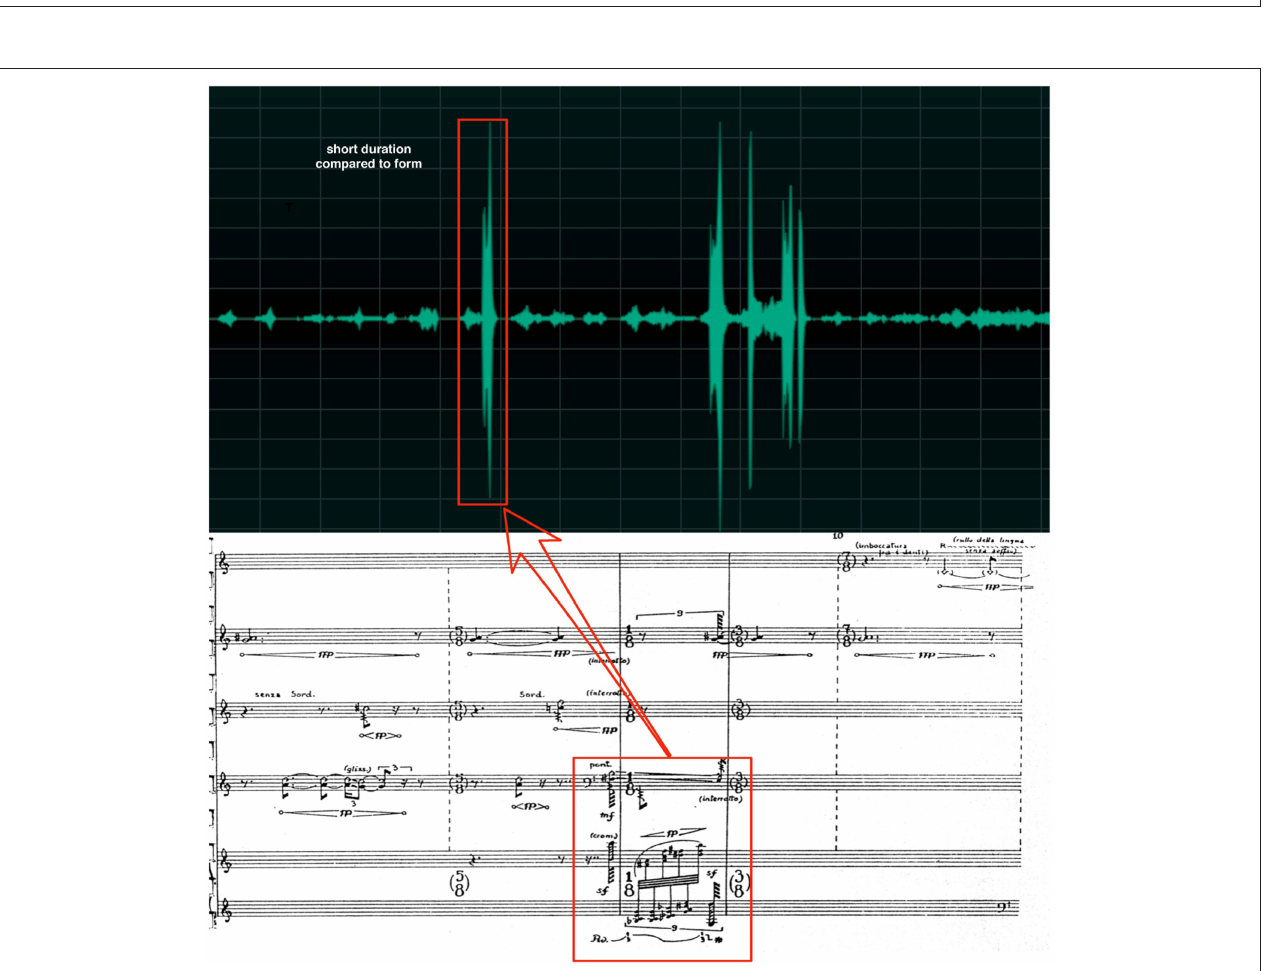
FIGURE 3 | The figure shows the beginning part of Salvatore Sciarrino’s Lo spazio inverso. For the majority of the piece, the dynamics is very soft (from ppp to p ) and the instrumentation does not include keyboards. All of a sudden, the keyboard is used in the piece with a dynamic of fff thus creating an immediate fracture in musical discourse. While these events are very scarse and sparse in time, they nonetheless represent the most important musical elements of the piece. In this context, a statistical approach aimed at finding most probable event, would classify the scarce phrases played by the keyboards as outliers while in reality they are actually the center of the musical